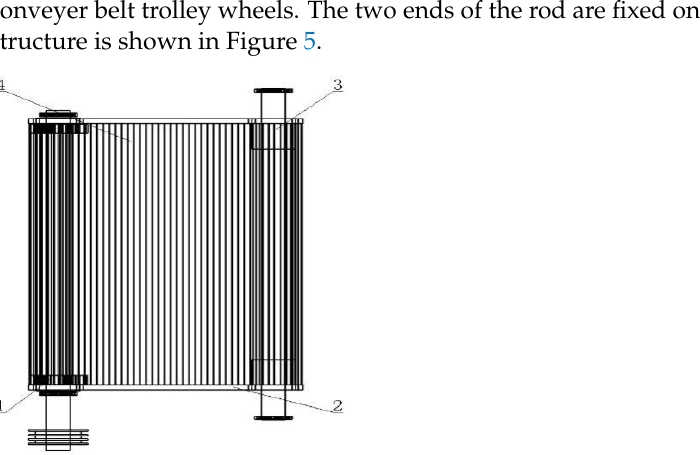
Figure 5. Structural diagram of rod-typed lifting device: 1. conveyer belt gear; 2. rubber belt; 3. con- veyer roller; 4. rod conveyer belt.